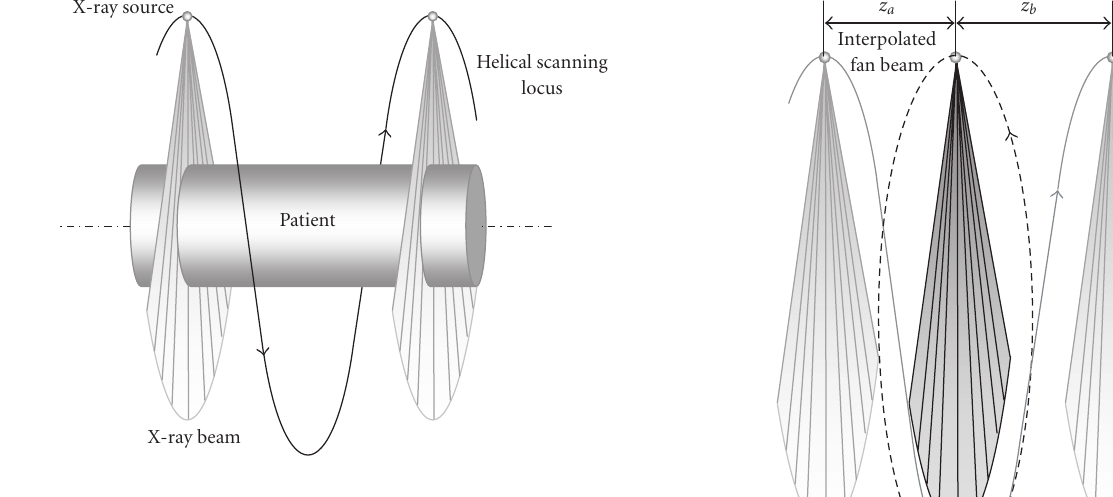
Figure 1: Scanning geometry with the patient static and source moving in a helical trajectory.